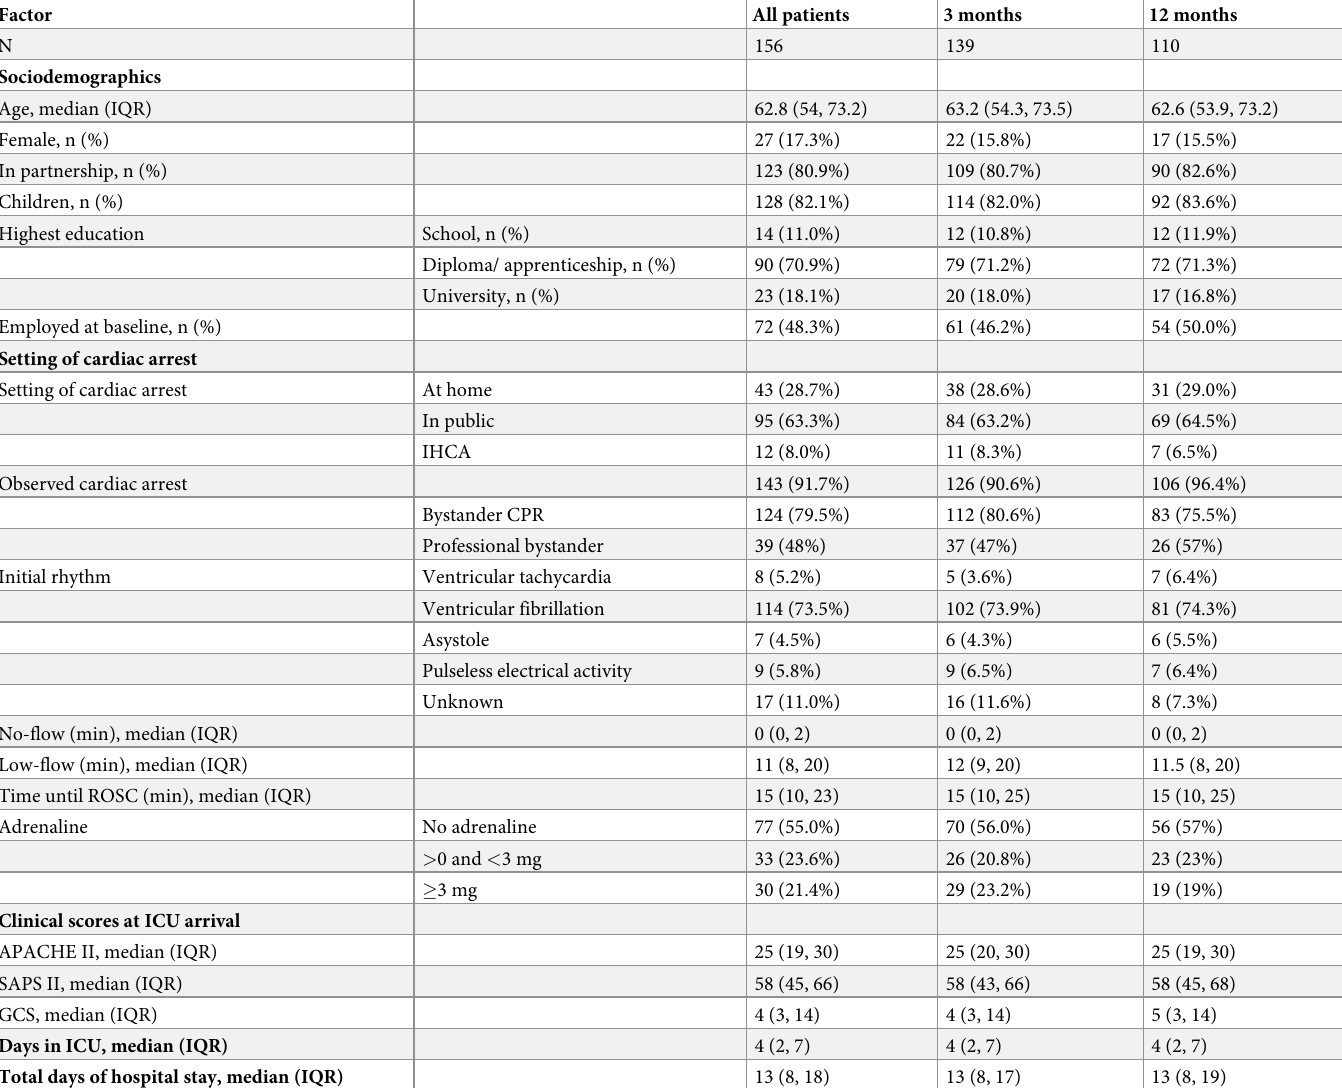
Table 1. Sociodemographic and clinical characteristics of the study